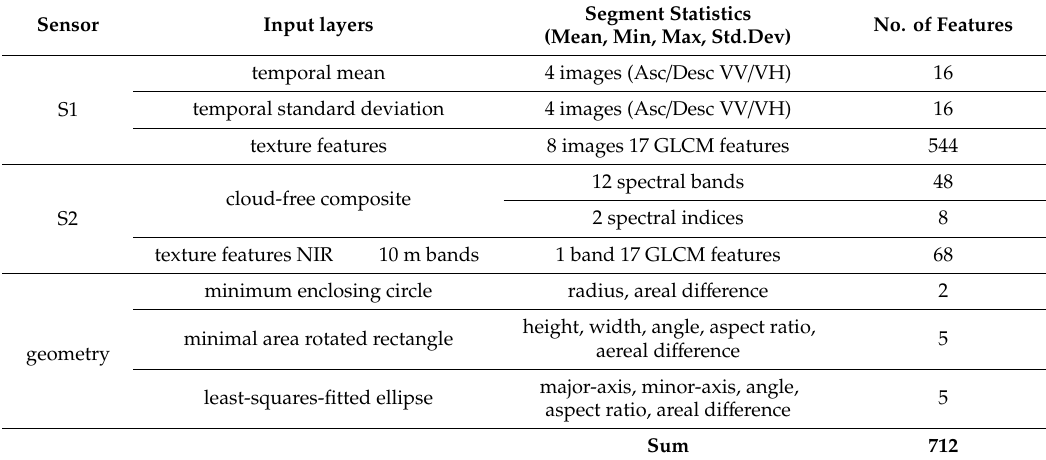
Table 4. Overview of all generated